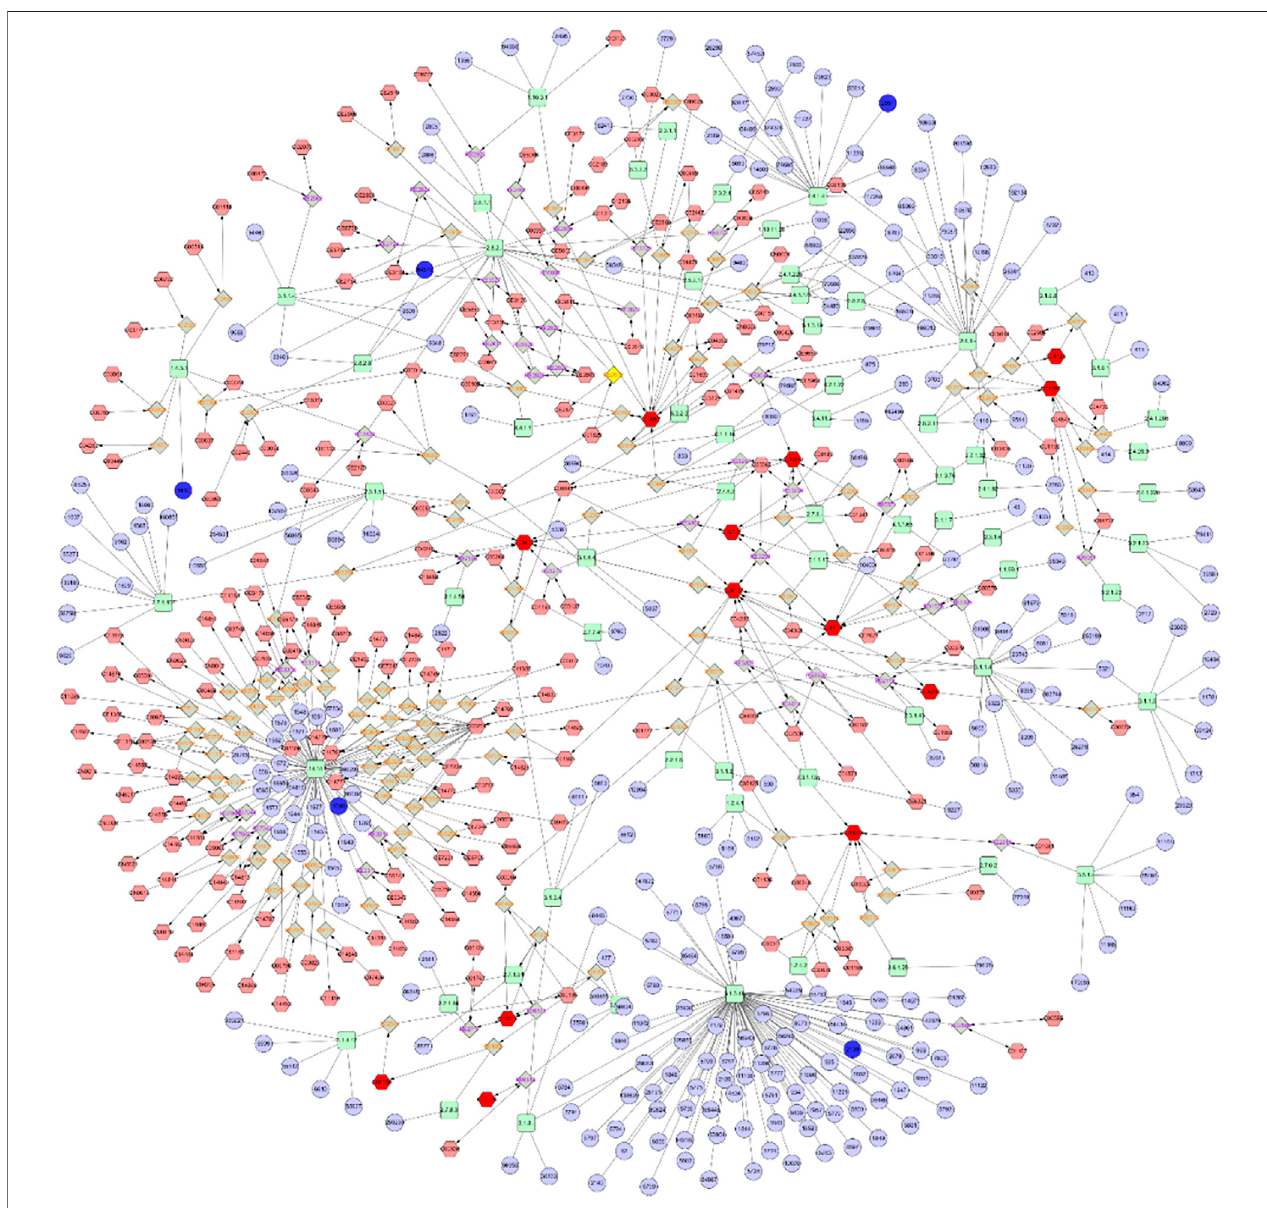
FIGURE 7 | Metabolite-To-Gene interaction